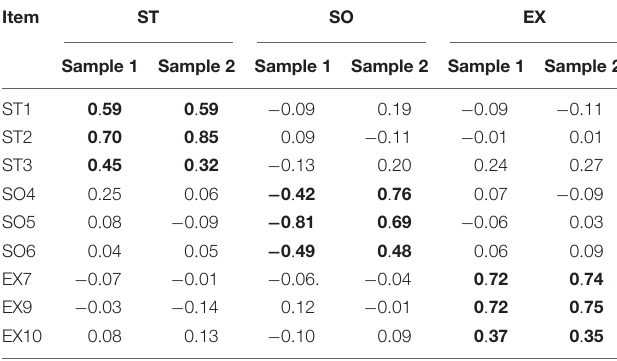
The abbreviations refer to the following study motives dimensions: ST = self- transcendent motives, SO = self-oriented motives, and EX = extrinsic motives. Factor loadings over 0.32 appear in